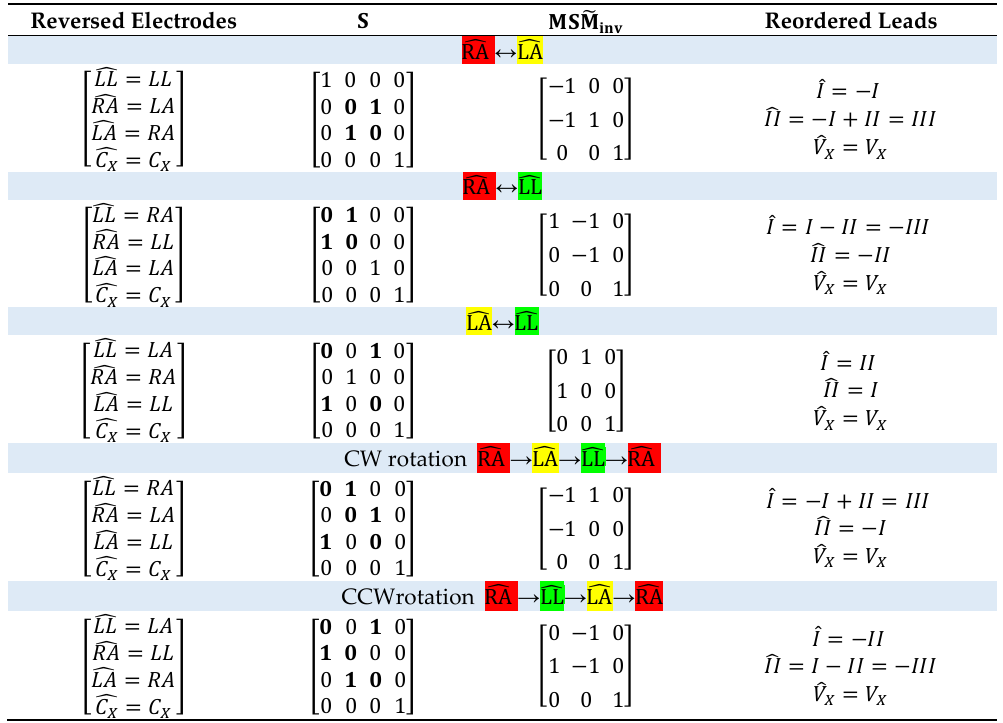
Table 2. Reversals of peripheral electrodes not involving RL.